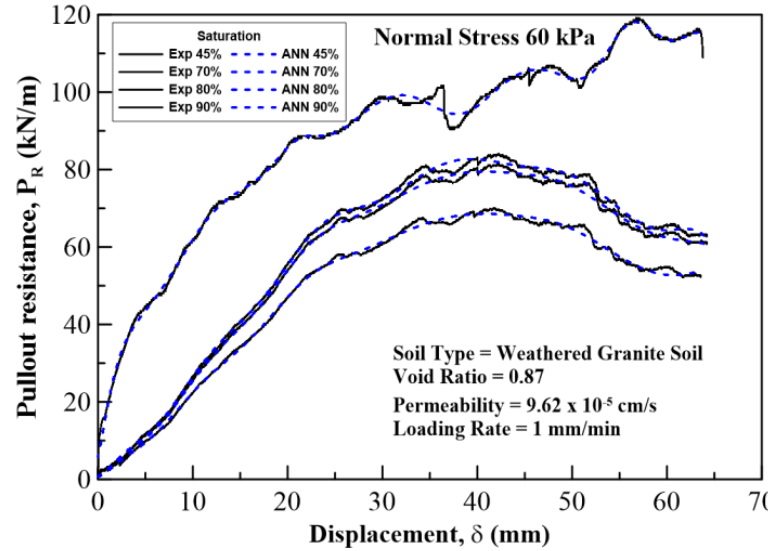
Figure 11. Pullout resistance vs. displacement curves plotted for a normal stress of 60 kPa at 45%, 70%, 80%, and 90% degree of saturation of the soil. Solid lines show experimental results, and the dotted lines show ANN results.